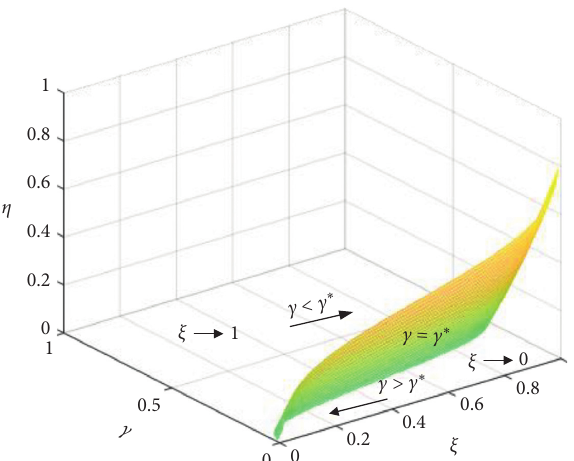
Figure 3: Evolutionary phase diagram of local government’s strategy